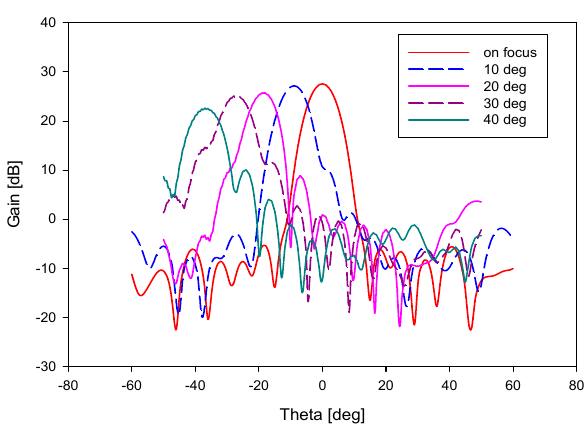
Figure 15. Antenna gain for scanning angle 0° to 40°. Table 8. Simulation results of multibeam.